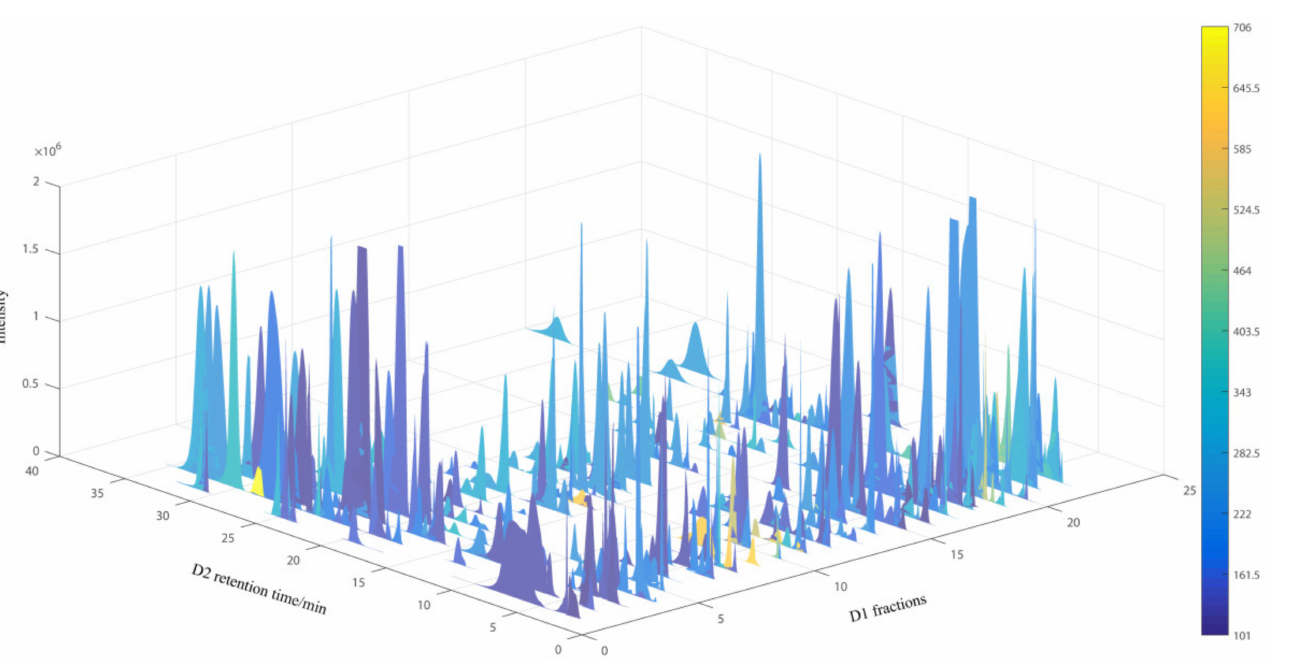
Figure 5. The four-dimensional plot of 2D RPLC × HILIC-Q-TOF-MS for the analysis of polar com- pounds in C. kwangsiensis (positive mode). Color bars represent the measured masses of components by